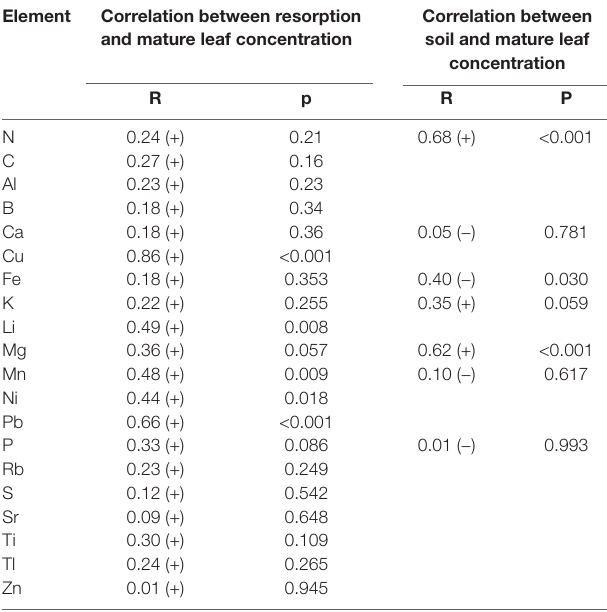
Signs in parentheses indicate if the correlation is positive (+) or negative